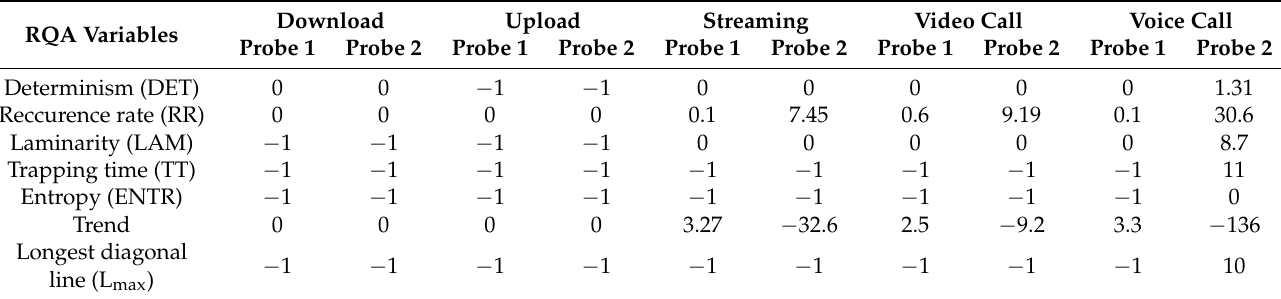
Figure 9. Recurrence plots corresponding to all five mobile applications emissions measured by E-field Probe 1 and Probe 2. Table 3. The RQA parameters for all five mobile